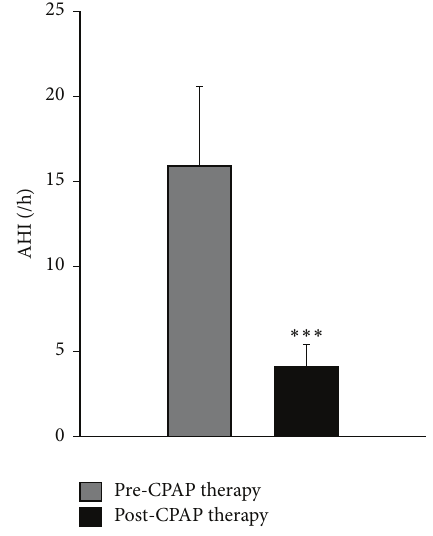
Figure 2: Effect of continuous positive airway pressure (CPAP) therapy on apnea-hypopnea index (AHI) in 13 obstructive sleep apnea (OSA) patients. ∗∗∗ 𝑃 < 0.001 pre- versus post-CPAP therapy.